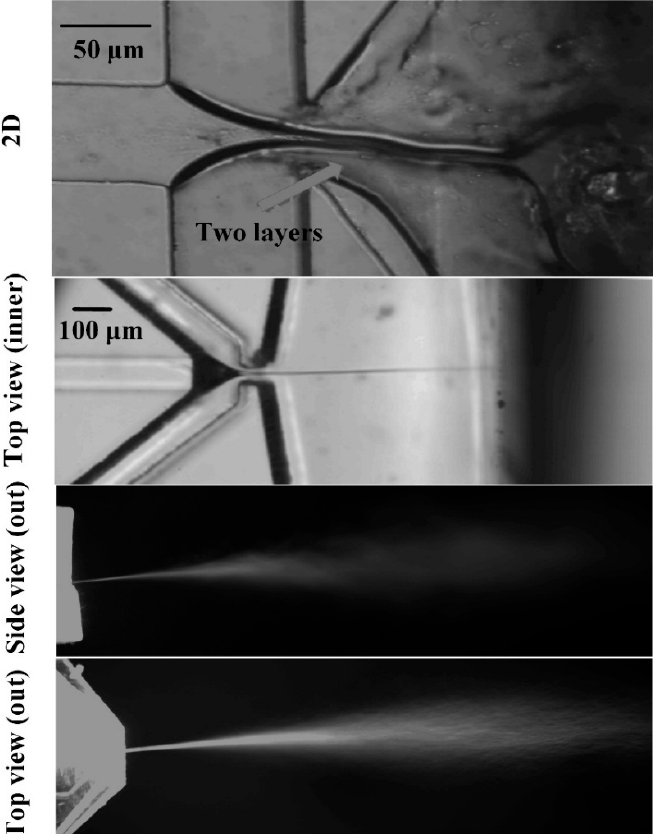
Figure 3. Spray effect of the 2D and 3D microfluidic chips. Pressures on the continuous and dispersed phases were 300 and 210 mbar, respectively. High voltage (2 kV) was added on the dispersed phase. The arrow pointed to the two layers of the liquid separated by the shear force of the walls.